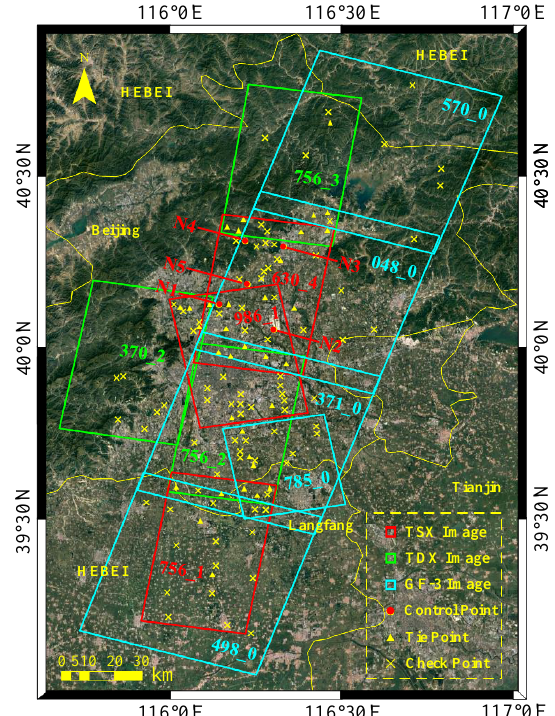
Figure 3. Geographical position and point’s distribution of study